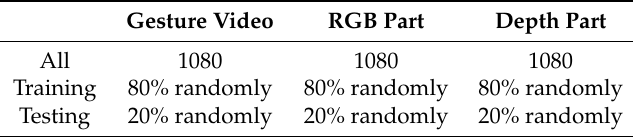
Table 3. Statistical information of SKIG dataset.